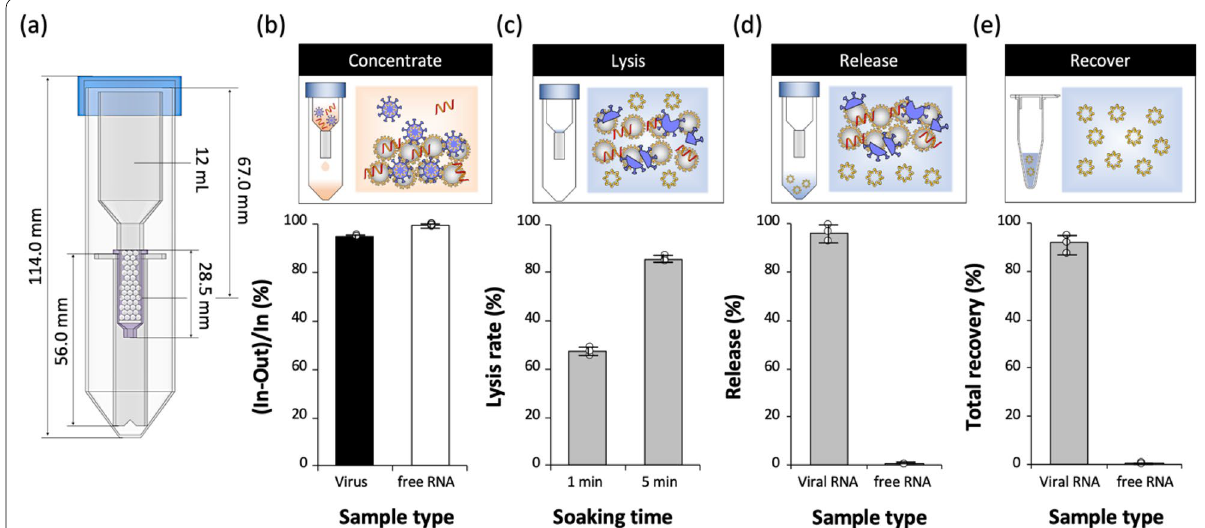
Fig. 3 New sample preparation protocol and kit to isolate only target RNA in virus, not free RNA fragments; a sample tube and filter column consisting of GO‑coated microbeads, b adsorption efficiency (%) of virus and free RNA fragments on the GO surface, c virus lysis efficiency,